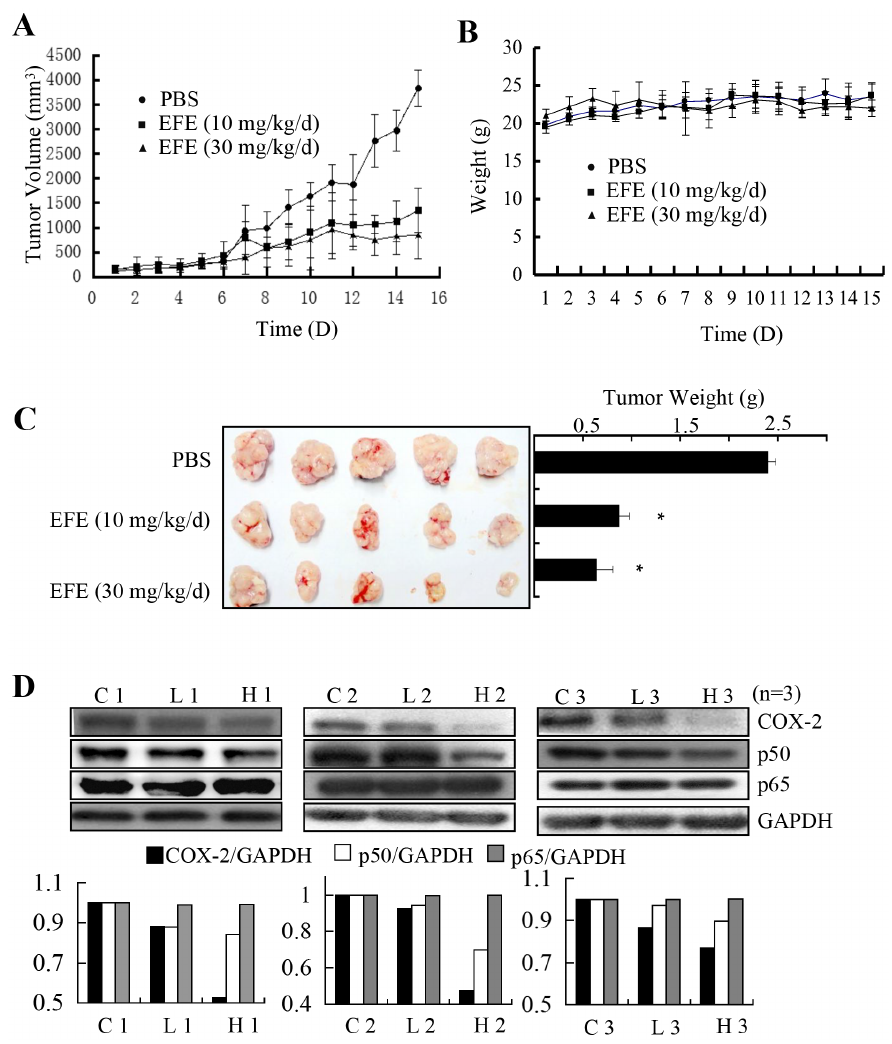
Figure 6. Effusanin E suppressed tumor growth in a human NPC nude mice model. ( A ) Tumor volumes measured in situ and images of the mice that were treated with the negative control (20 m l DMSO and 80 m l PBS) or effusanin E (EFE) at the indicated doses. The mice were randomly separated into three groups and treated with the negative control or effusanin E, and the tumor volumes were measured every other day. ( B ) Weight changes of the nude mice were measured after treatment every other day. ( C ) The weight of the tumors from the mice and images of tumors that were removed from the mice. After the mice were sacrificed, the tumors were removed from the mice and pictures were taken. ( D ) Representative Western blot showing the expression of COX-2, p50 and p65 in the tumors from nude mice. C1, C2 and C3 represent tumor 1, tumor 2 and tumor 3 from negative control. L1, L2 and L3 represent tumor 1, tumor 2 and tumor 3 from effusanin E-treated mice at 10 mg/kg/d. H1, H2 and H3 represent tumor 1, tumor 2 and tumor 3 from effusanin E-treated mice at 30 mg/kg/d. * represent P ,